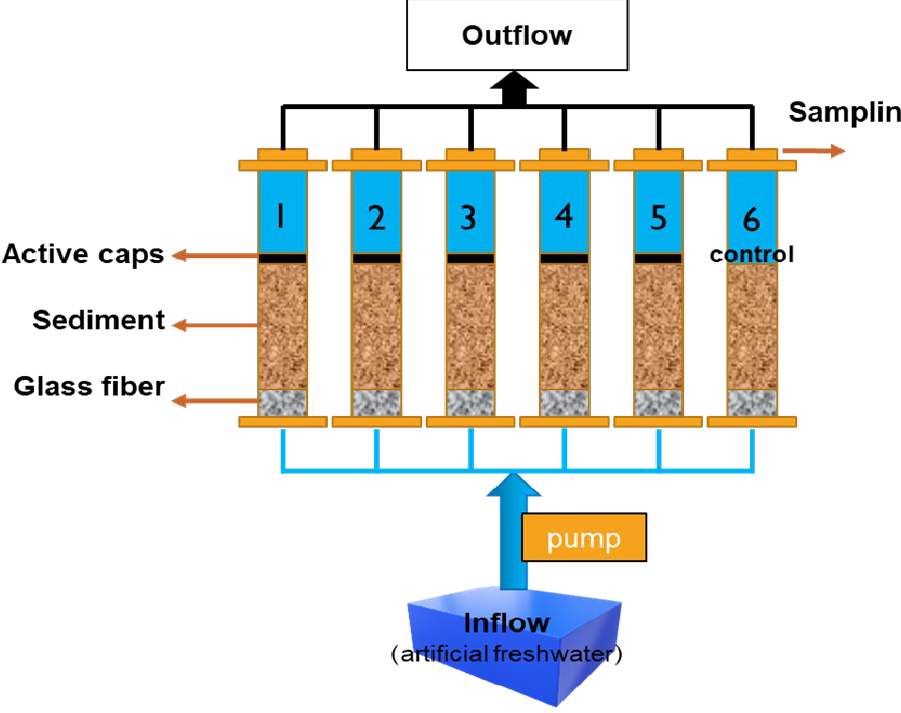
Figure 2. The lab-scale microcosm system.